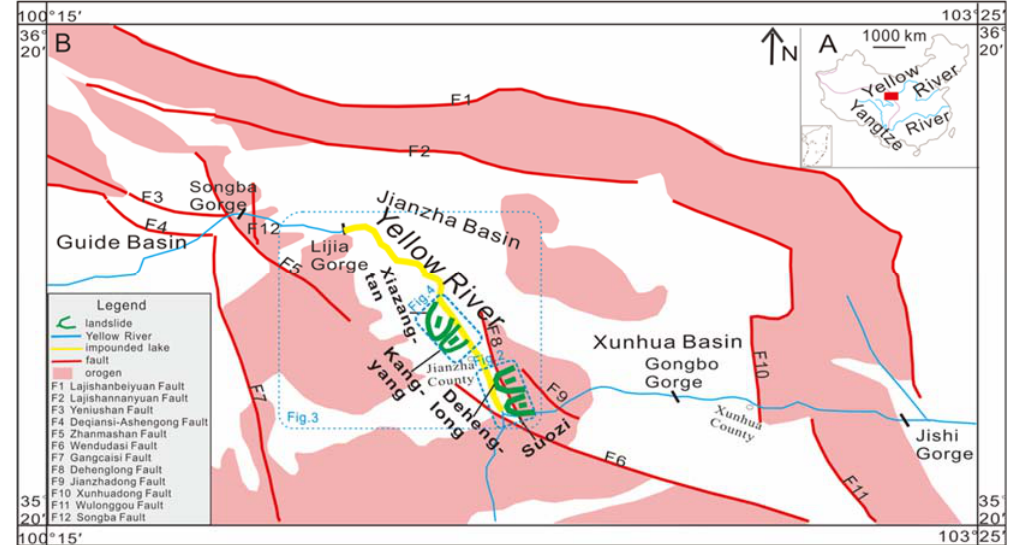
Figure 1. Map showing geographical location of the study area in China. ( A ) The small red rectangle denotes the locations of our study area. ( B ) Distribution of landslides and faults.